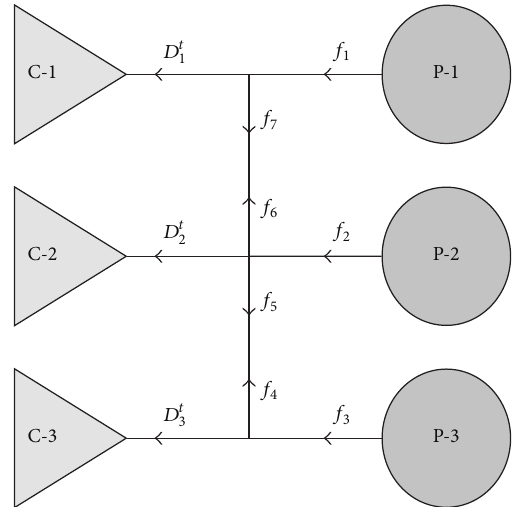
Figure 3: Simplified industrial gas network model with three (3) plants (P-1, P-2, and P-3) and three (3) customers (C-1, C-2, and C- 3). Arrows indicate the directions of gas